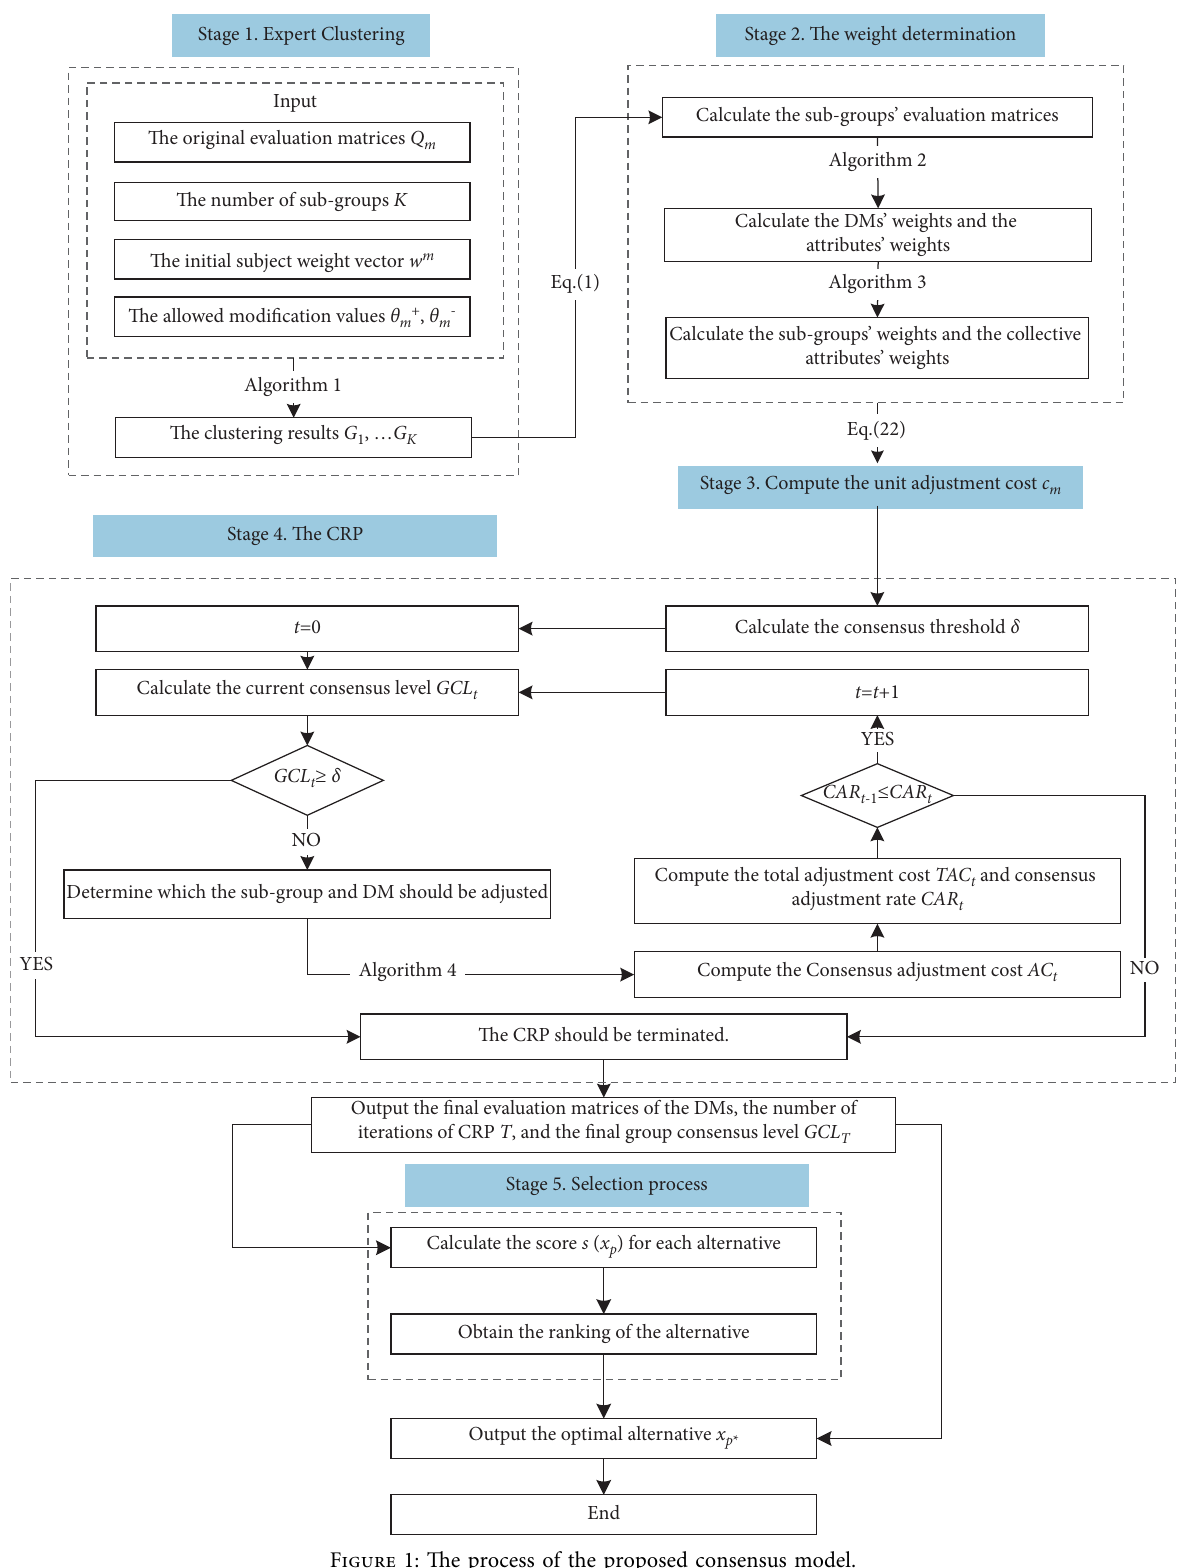
Figure 1: .e process of the proposed consensus